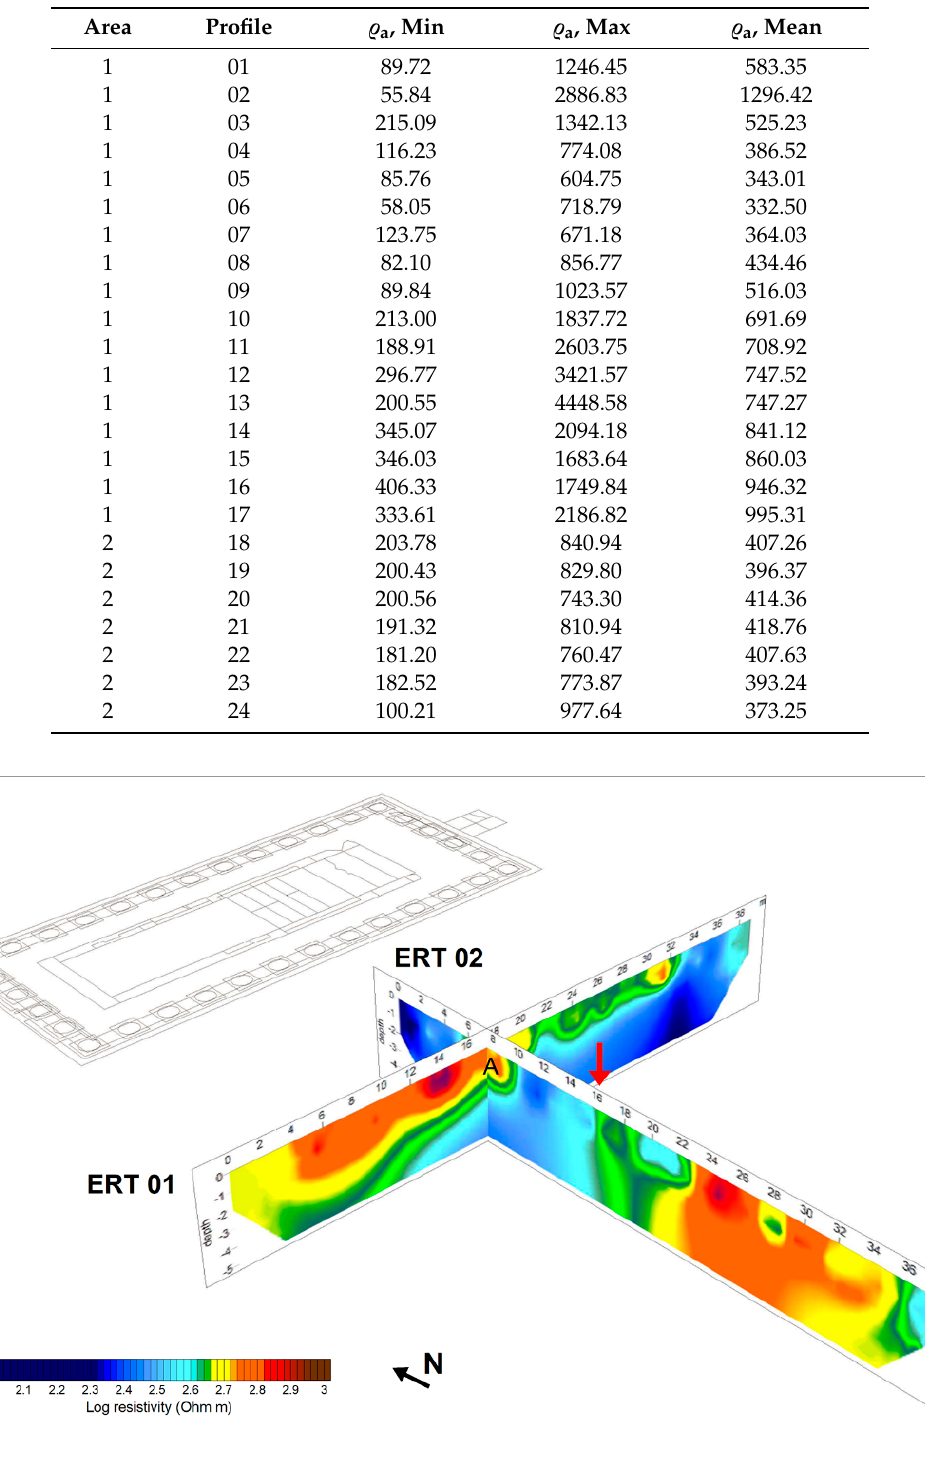
Table 1. Maximum and mean apparent resistivities in Ω m along the profiles.